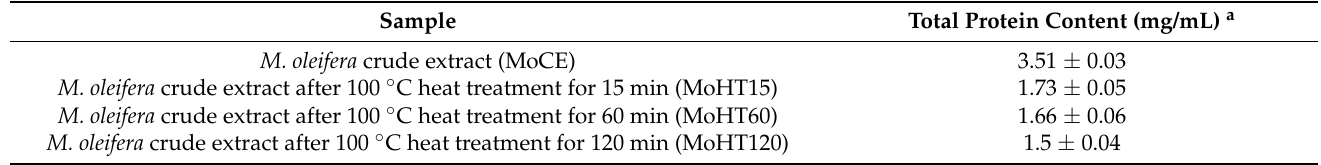
Table 1. Concentration for M. oleifera crude extract and heat-treated